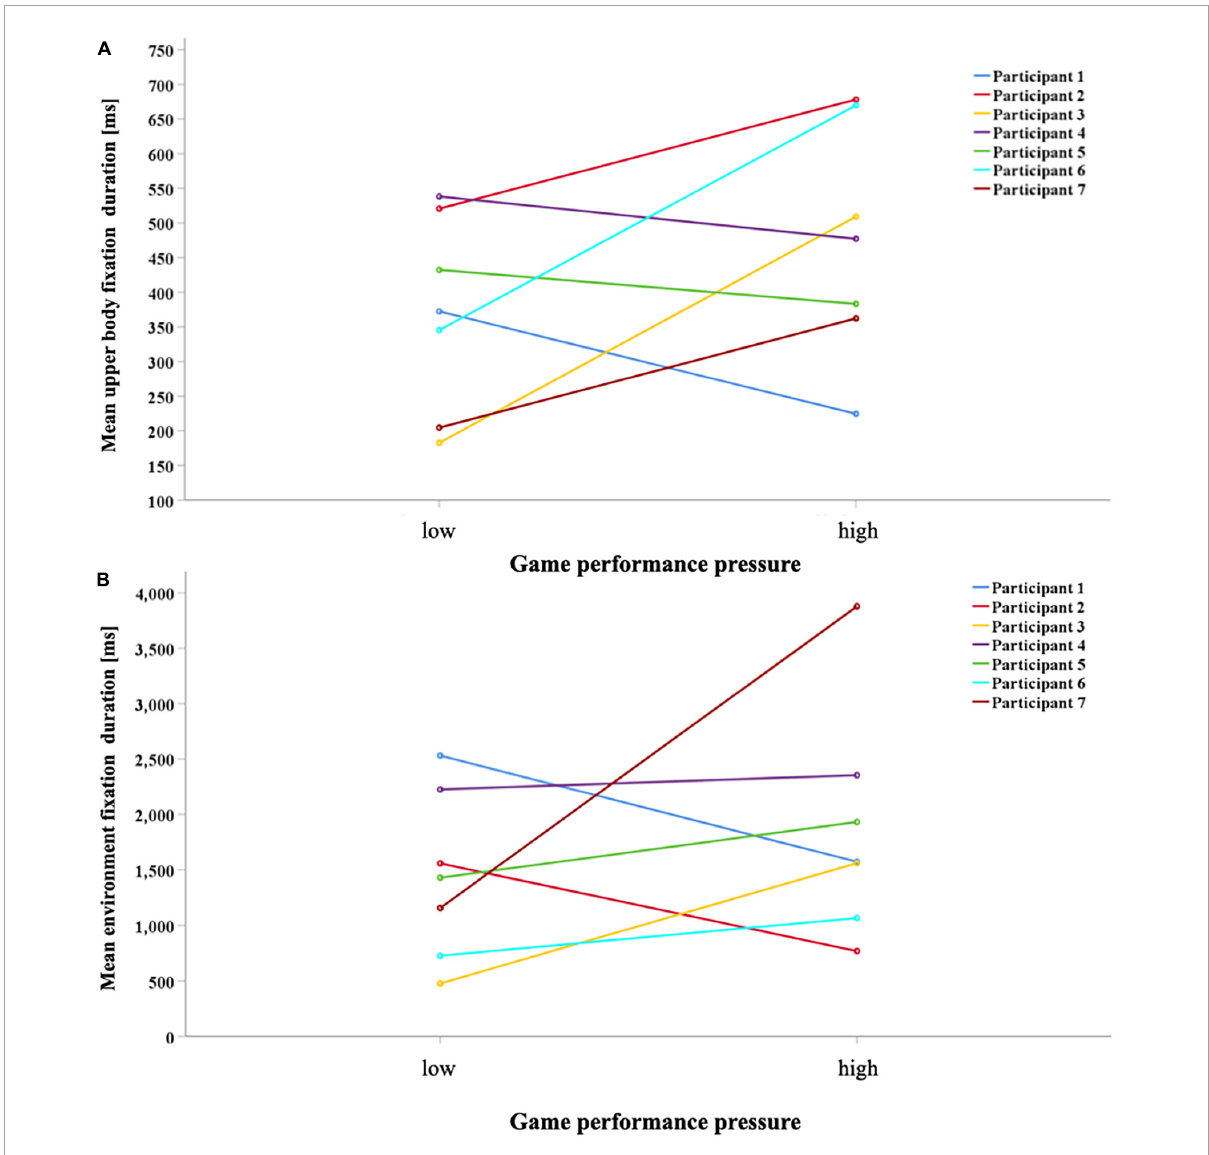
FIGURE3 Each participant’s mean fixation duration depending on the stress level on the upper body (A) and the environment (B)